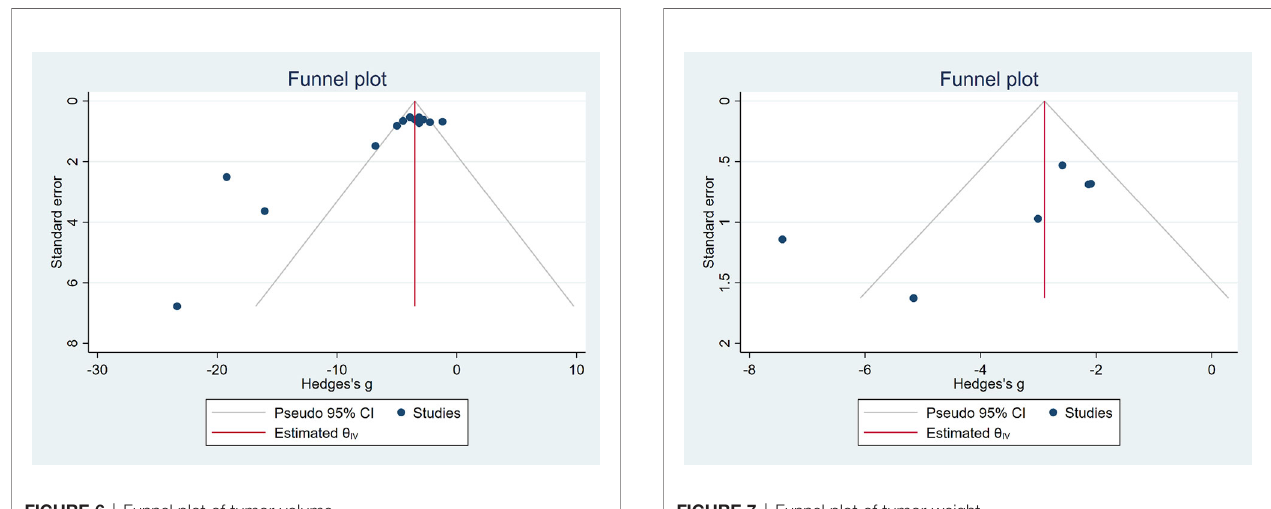
FIGURE 6 | Funnel plot of tumor volume. FIGURE 7 | Funnel plot of